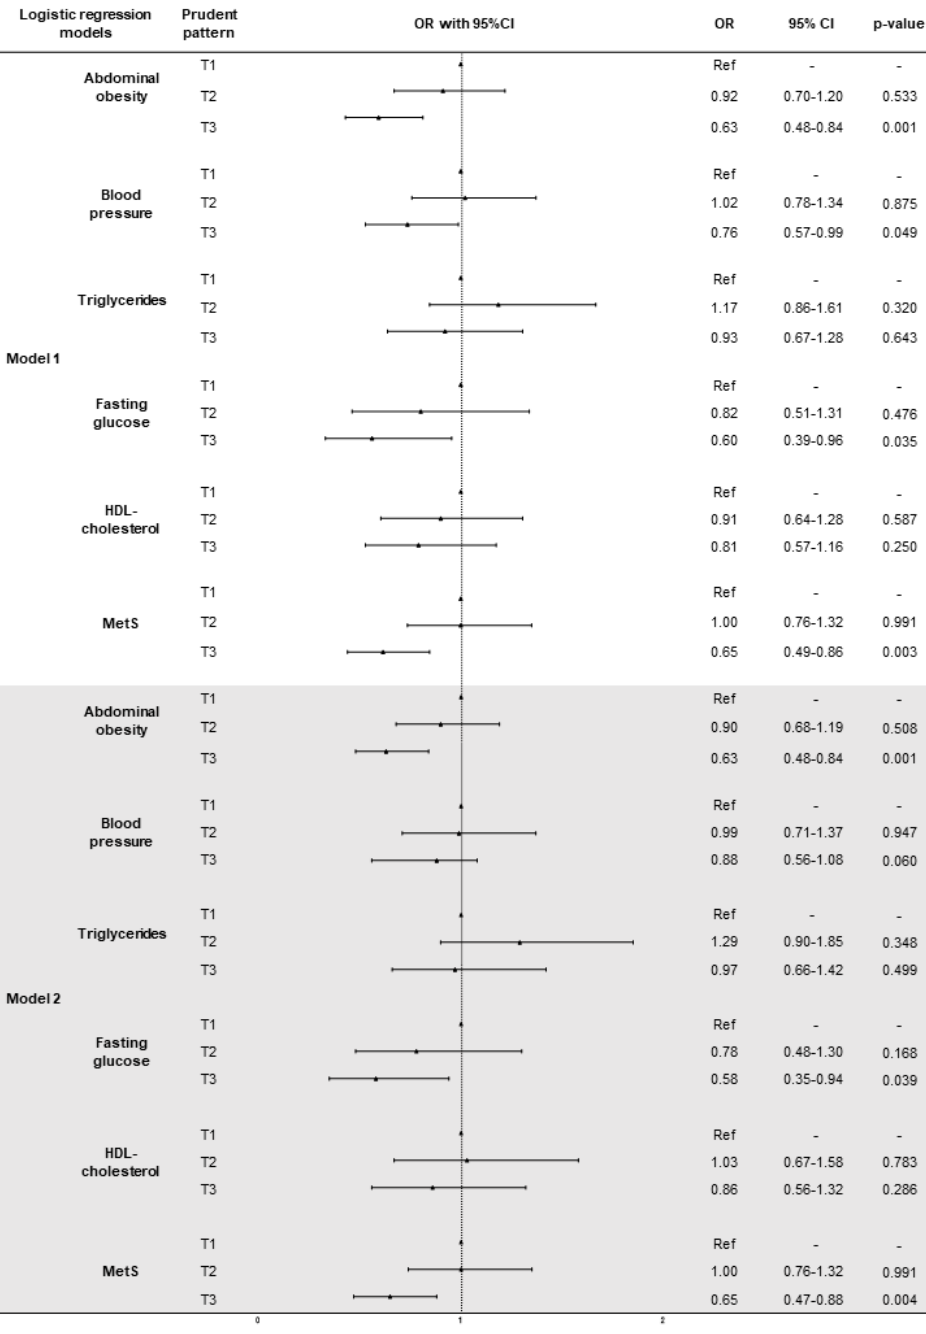
Figure 5. Logistic regression models of the association between prudent dietary pattern, MetS and it components. Abbreviations: OR, odds ratio; CI, confidence interval; T, tertile; MetS,